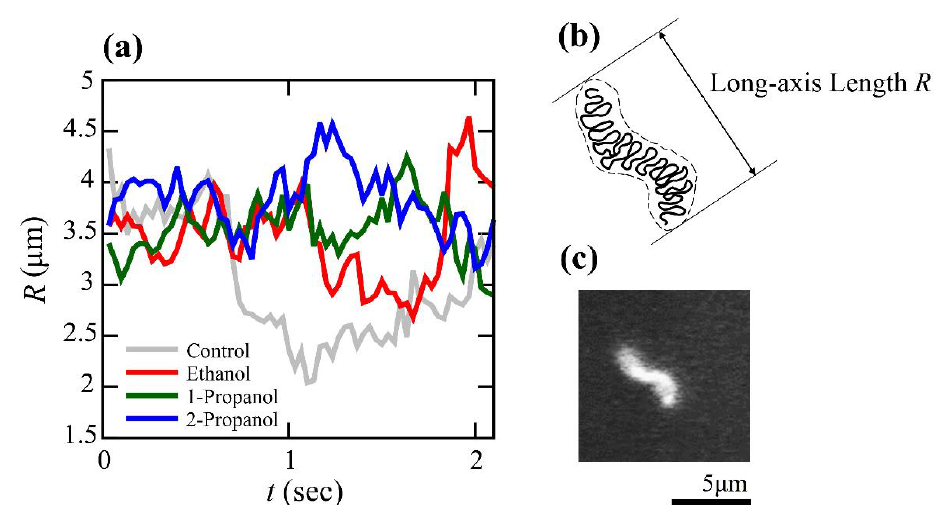
with 4% 1-propanol, and ( d ) with 4% 2-propanol.